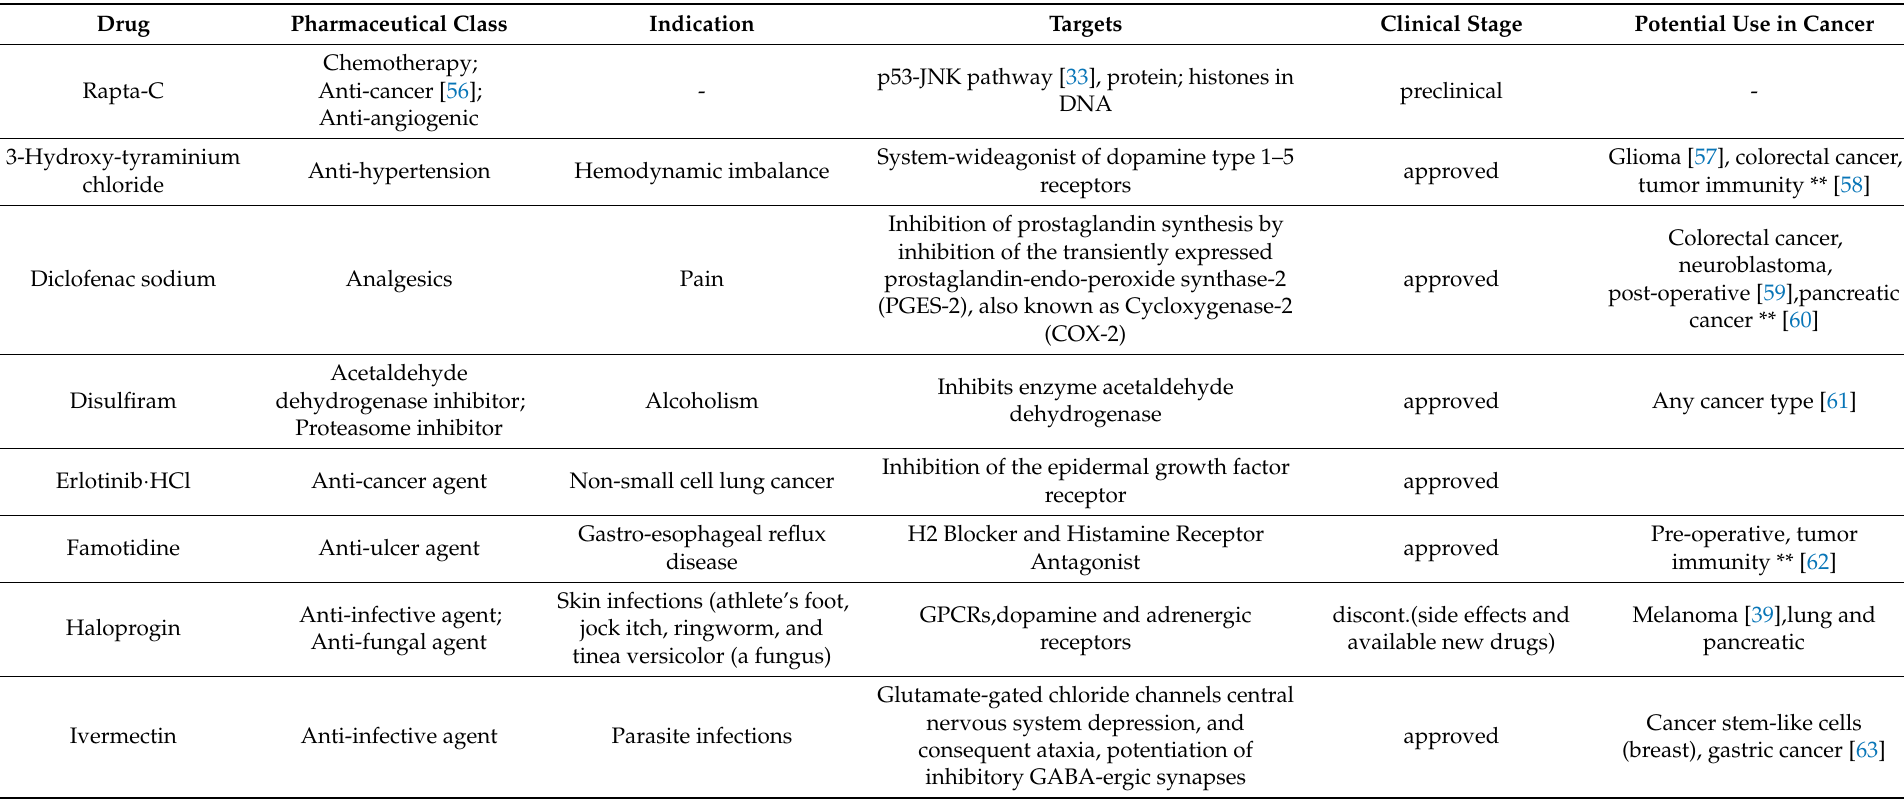
Table 1. Drug–drug interactions and efficacy in cancer